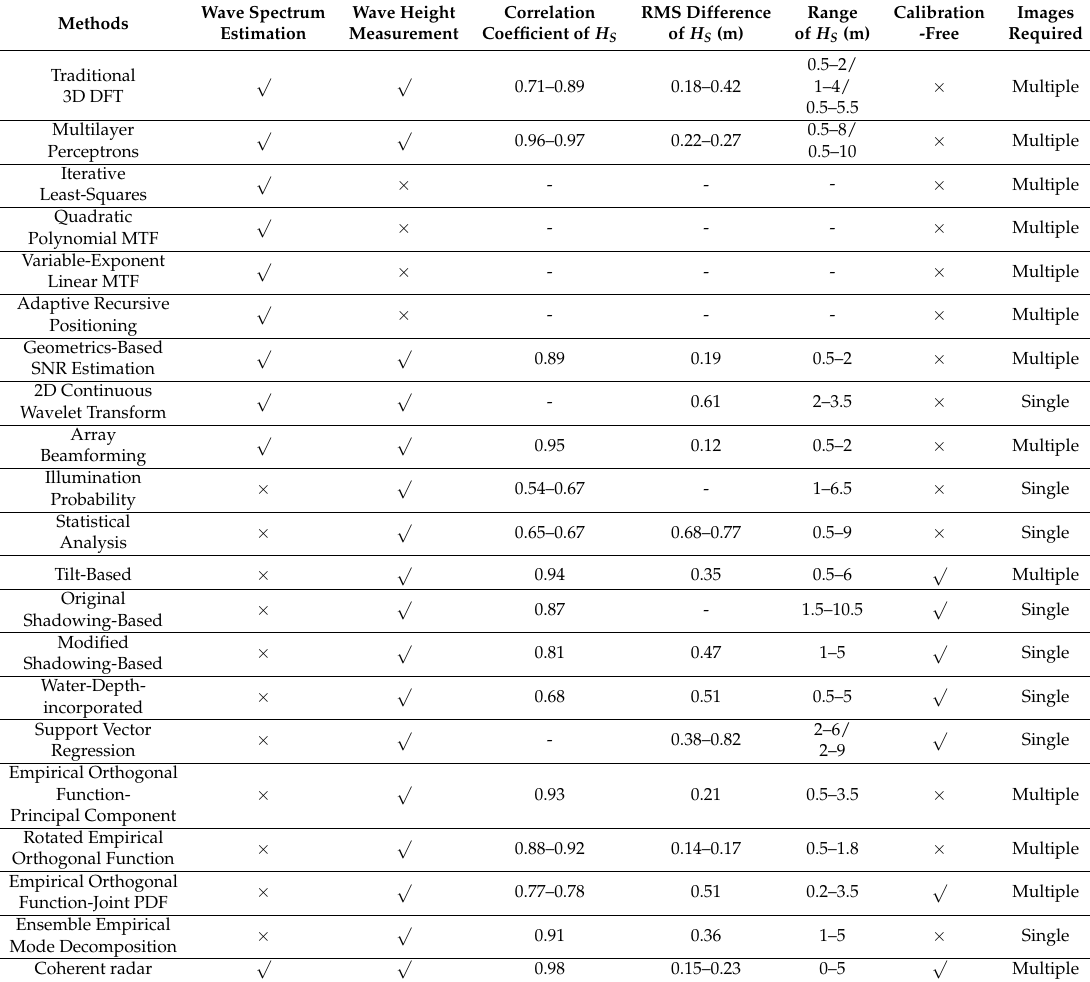
Table 2. Inter-Comparison of the Reviewed Wave Measurement